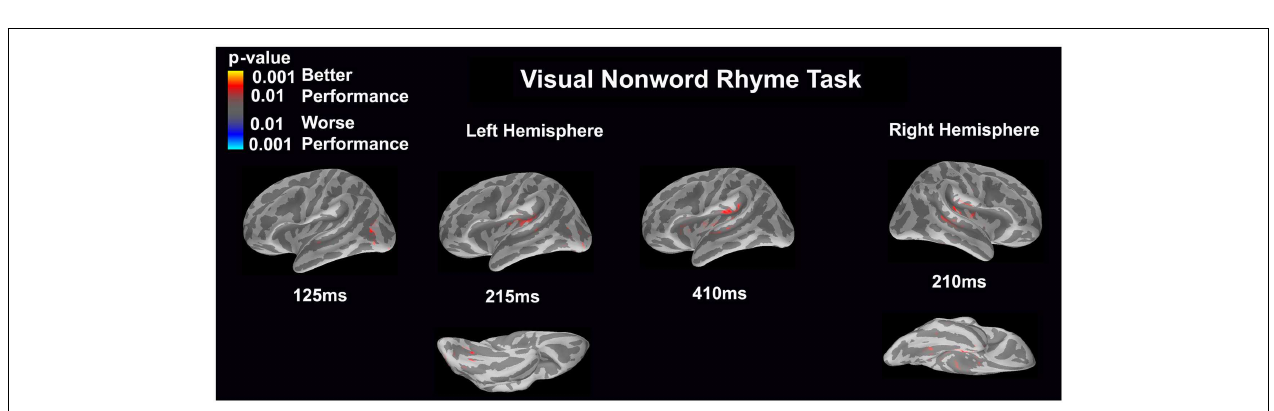
associated with worse performance. Performance was based on the individual participant’s non-word reading ability as indexed by the scaled score on theWoodcock–Johnson IIIWord Attack